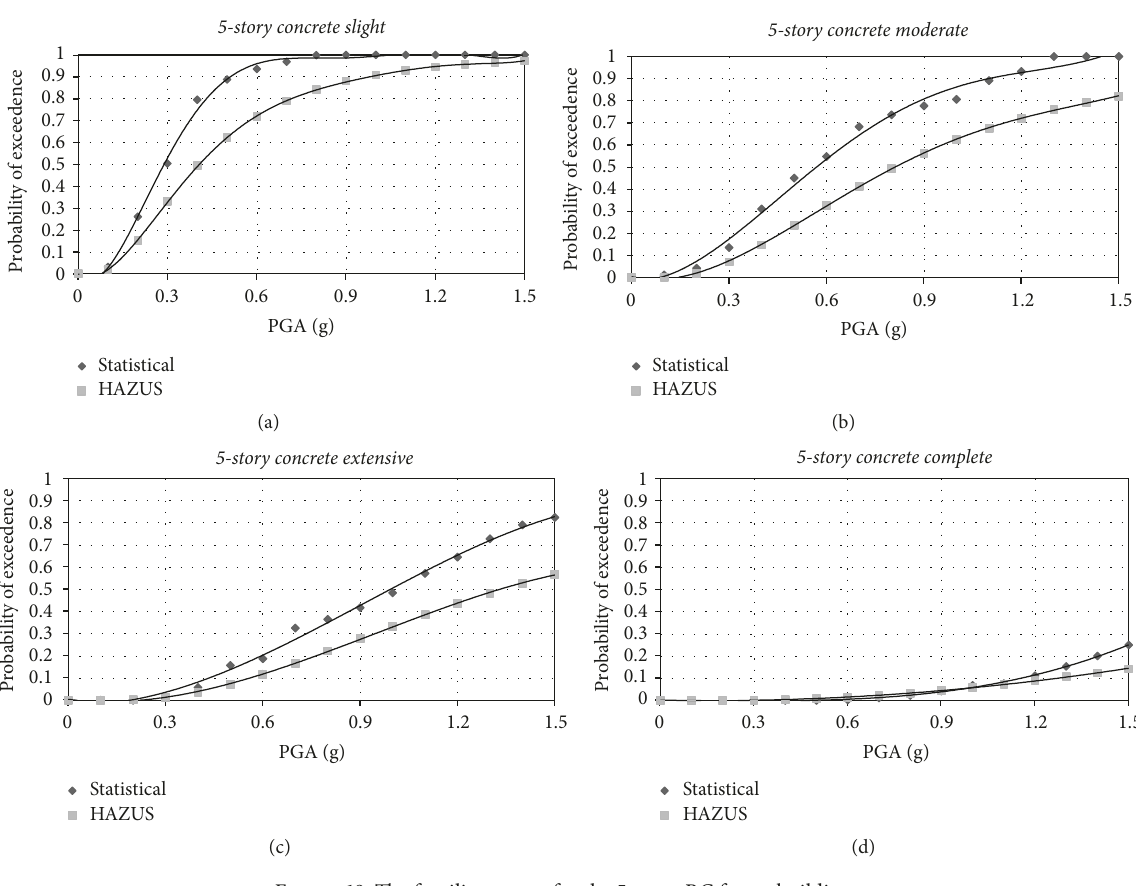
Figure 18: The fragility curves for the 5-story RC frame